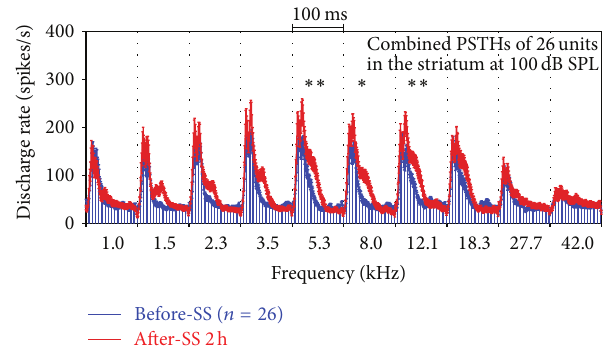
Figure 6: Averaged PSTHs of 26 units recorded in the Str showing significant effect (enhancement) in the midfrequency region (5.3, 8.0, and 12.1kHz). The PSTHs were obtained before (blue) and after SS injection (red). Stimulation: 50 ms tone bursts at 100dB SPL and at different frequencies; treatment: SS (250 mg/kg, i.p.). The vertical bars are SEs. ∗∗ 𝑃 < 0.01 ; ∗ 𝑃 < 0.05